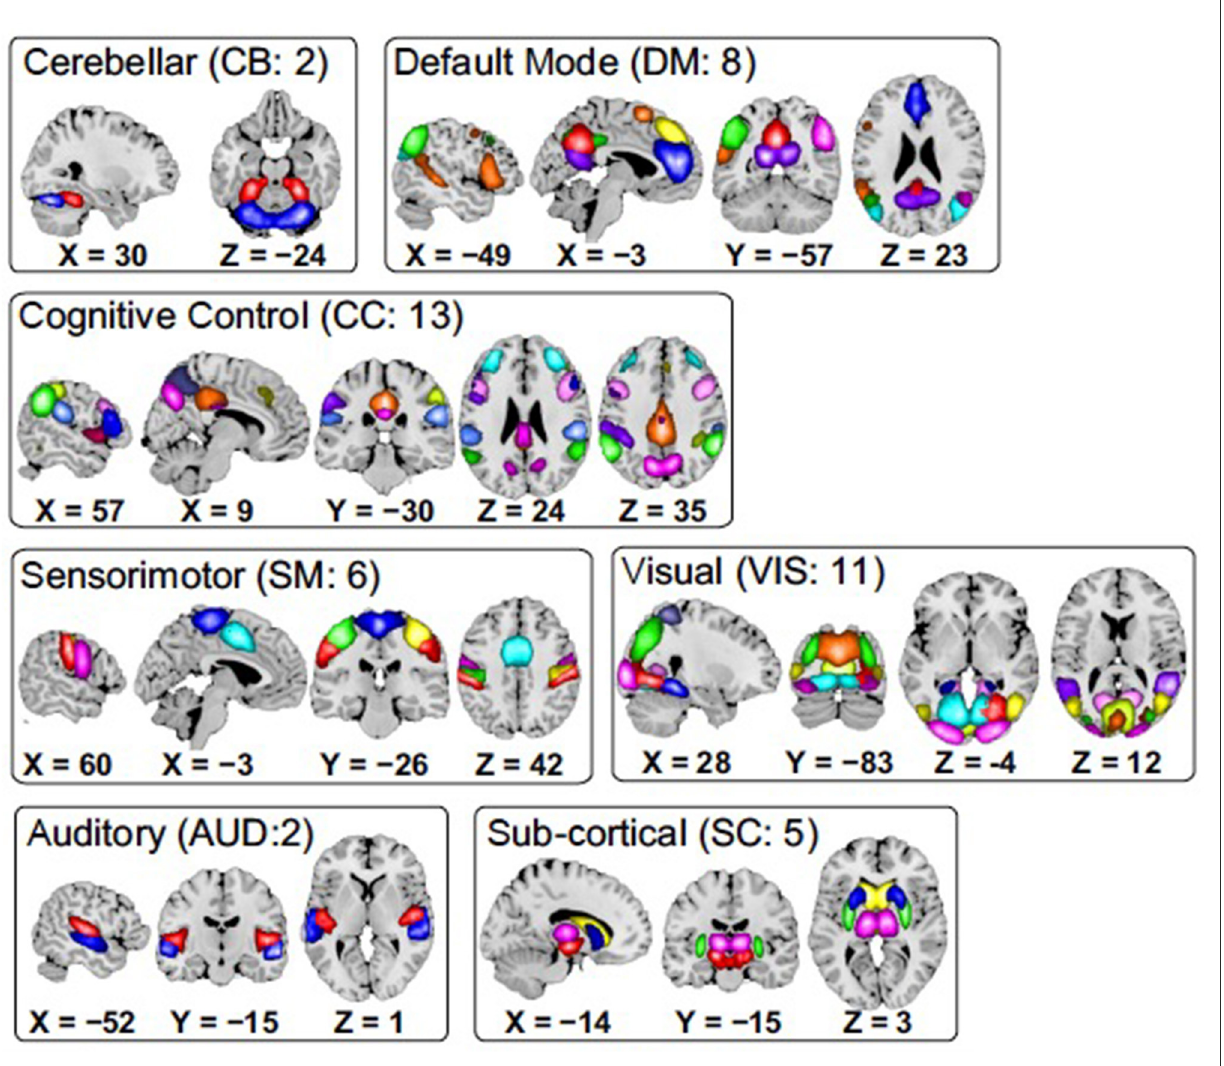
FIGURE3 Spatial maps of the 47 identified brain components, grouped into seven subcategories. Each color in the maps within each domain corresponds to a unique